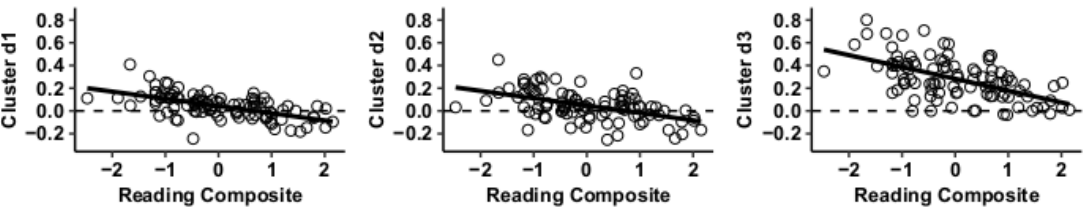
Figure 6. Whole-brain functional connectivity correlations with reading composite score for MVPA Cluster d.